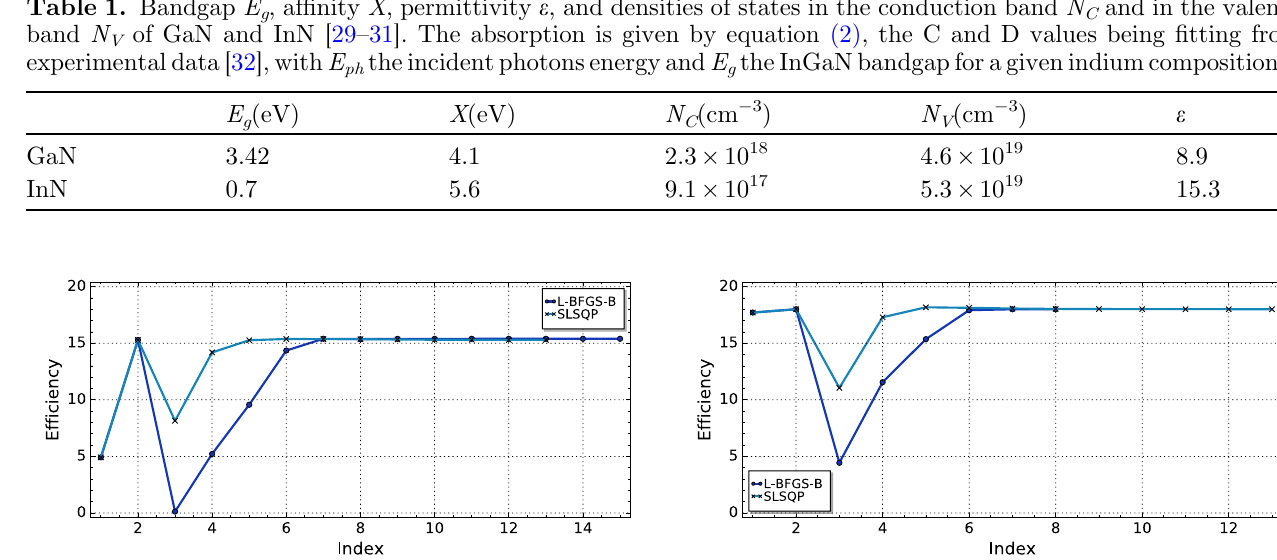
Fig. 4. Ef fi ciency of the InGaN PN solar cell determined by SLALOM using the L-BFGS-B and SLSQP methods, with the initial point chosen relatively far from the global optimum.